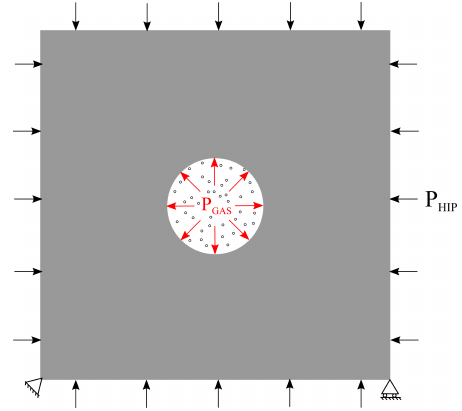
Figure 4. Planar view of a gas-filled spherical pore subjected to external applied load P HIP . The pressure exerted by the trapped gas on the pore surface is represented as P GAS .